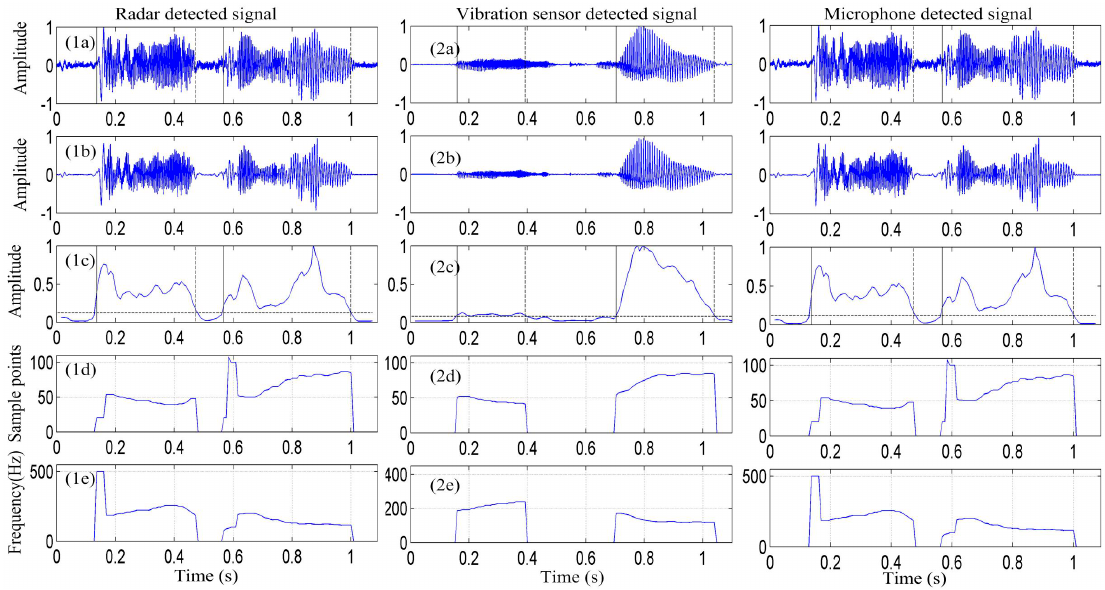
Figure 9. Pitch contours of the signals detected by the radar system, vibration sensor, and microphone system for the spoken word, “welcome,” obtained using the EMD-ACF algorithm. ( a ) Original detected signal; ( b ) enhanced speech obtained using the EMD method; ( c ) voice activity detection using the ratio of the energy and entropy spectra; ( d ) pitch period of the detected signal; and ( e ) vocal-fold vibration frequency of the detected signal.